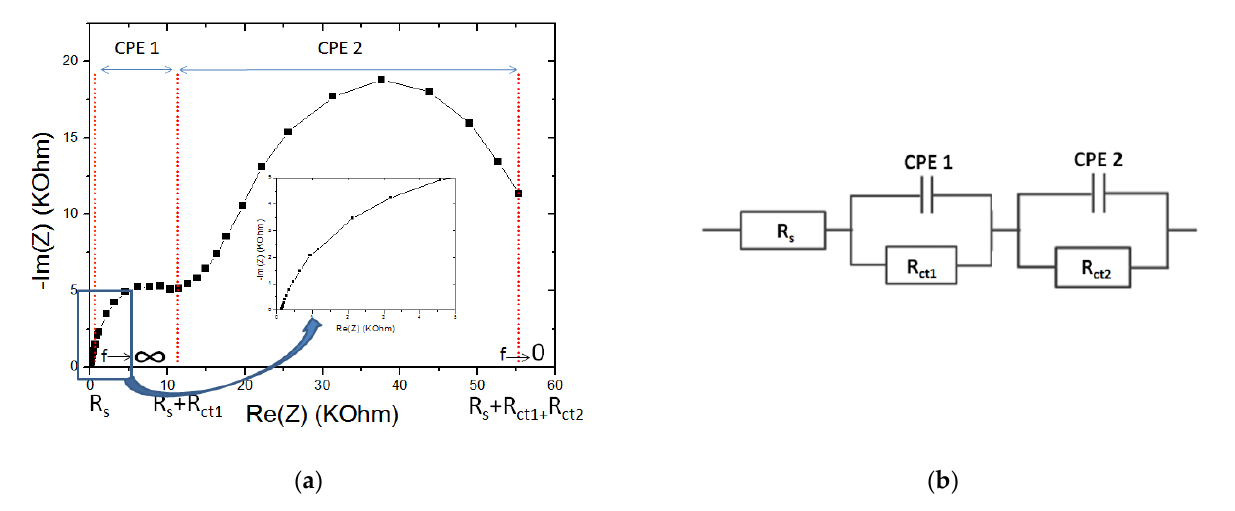
Figure 1. ( a ) EIS of the microsensor (E = 0.2 V. Freq =100 kHz − 100 mHz) in PBS with 5 mM [Fe(CN)6] 3 − /4 − . ( b ) Equivalent electrical circuit (Rs + CPE1/Rct1+ CPE2/Rct2).